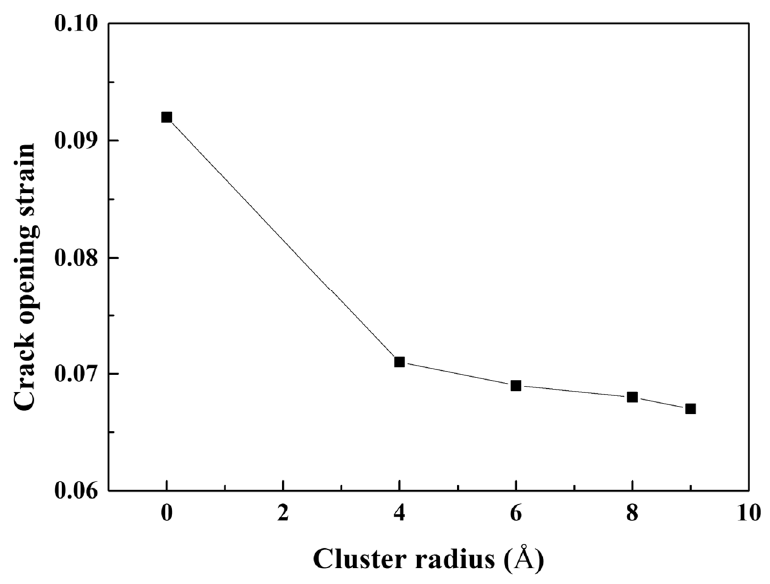
Figure 6. Crack-opening strains of the cracked Al containing an Mg–Si cluster as a function of the Mg–Si cluster radius.